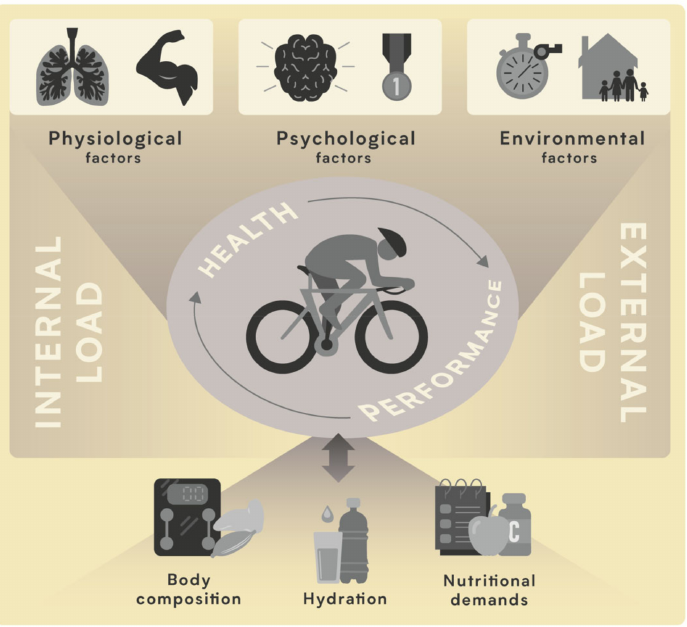
Figure 1. Graphical summary of the main performance and health determining factors of young competitive